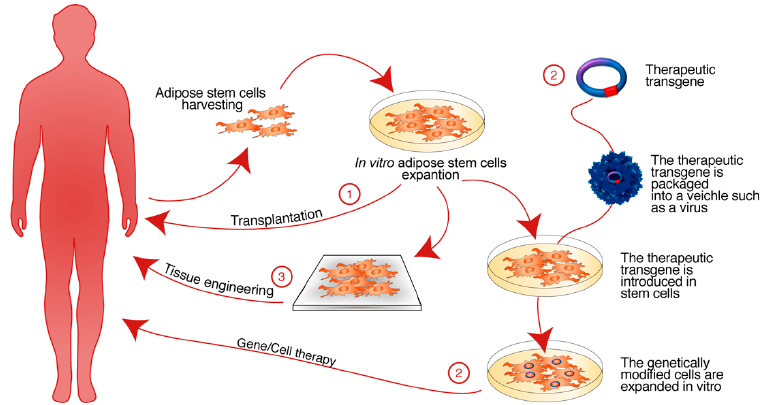
Figure 3. Regenerative medicine paradigm. The cartoon schematizes the three current strategies of regenerative medicine: (1) Transplantation. Autologous ASCs are expanded in vitro and are implanted in the host recipient tissues directly (see Section 3.1). (2) Gene/Cell therapy. Autologous ASCs are expanded in vitro and are transduced with viral-vector carrying the therapeutic gene and then are implanted in the host recipient tissues (see Section 3.2). (3) Tissue Engineering. Autologous ASCs are expanded in vitro and are combined with biomaterials, then are implanted in the recipient host to regenerate damaged tissues (see Section